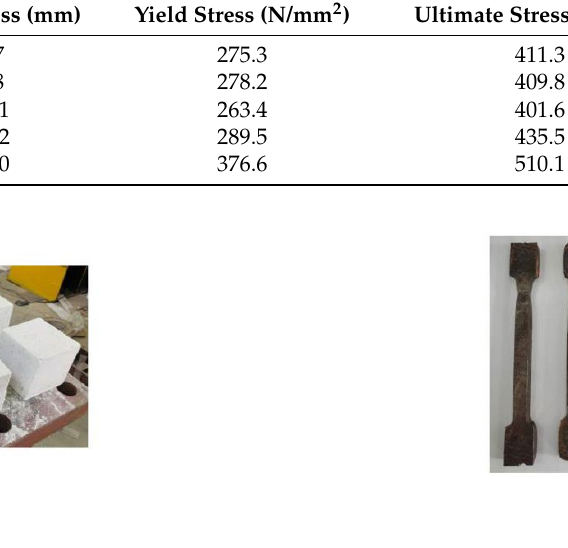
Figure 8. Test loading scheme detailed of the material properties test. ( a ) The ALC cubes. ( b ) Steel specimens.